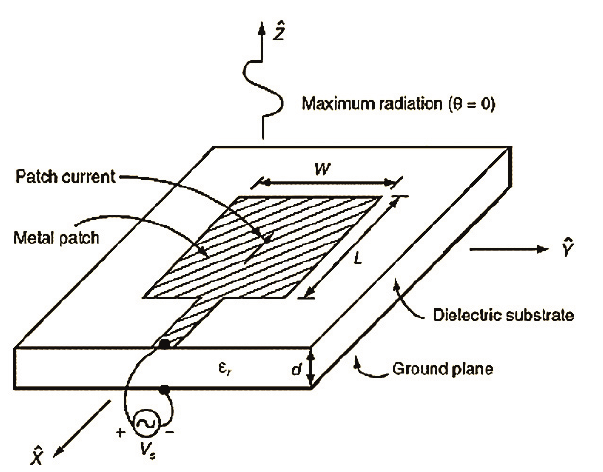
Fig. 2. Typical microstrip